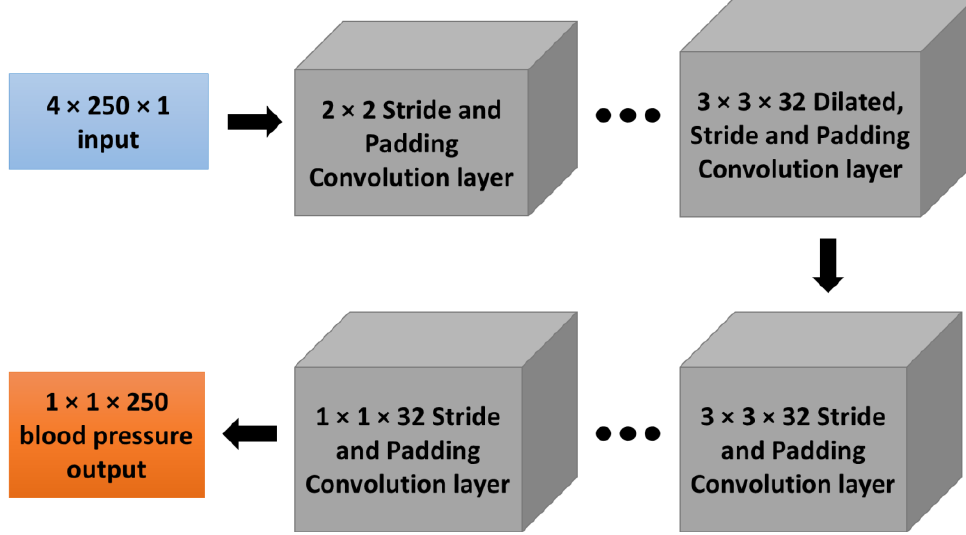
Figure 4. Context Aggregation Network (CAN) architecture with 4 × 250 data inputs for both magnitude and phase of ECG and PPG (4 × 250 pixels) in the frequency domain and 250 data outputs of blood pressure (1 × 250 pixels) in the time domain.